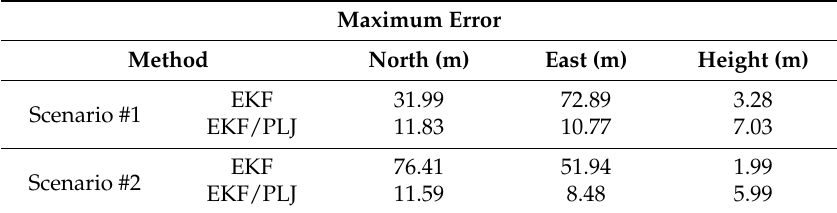
Table 2. North, East & Height Errors.